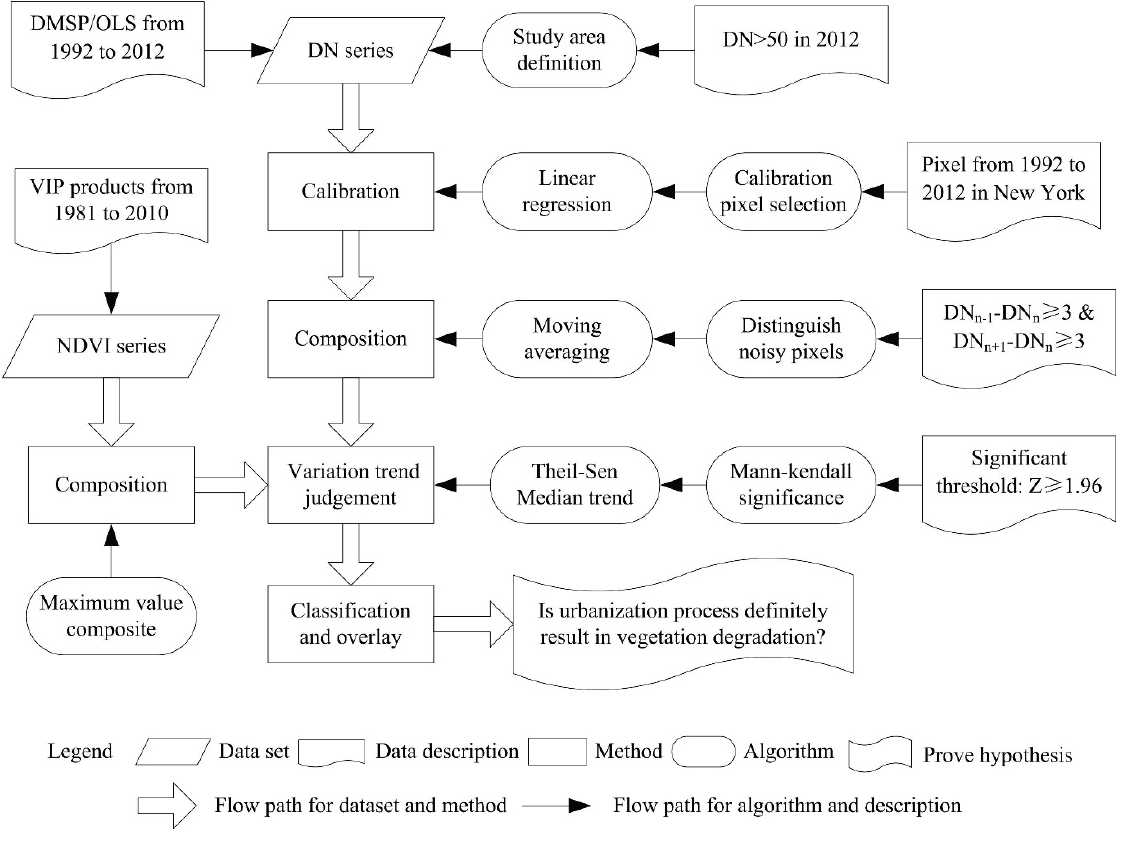
Figure 2. The flowchart for this